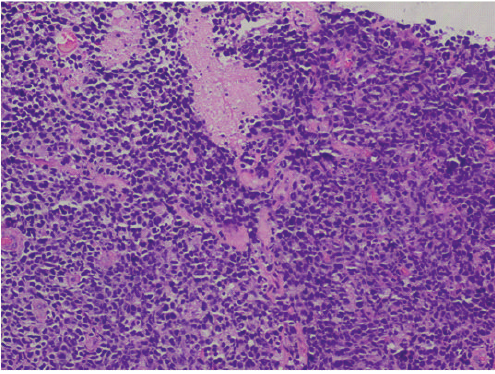
Figure 4: KI67 nuclear positivity of majority of the tumour cells.